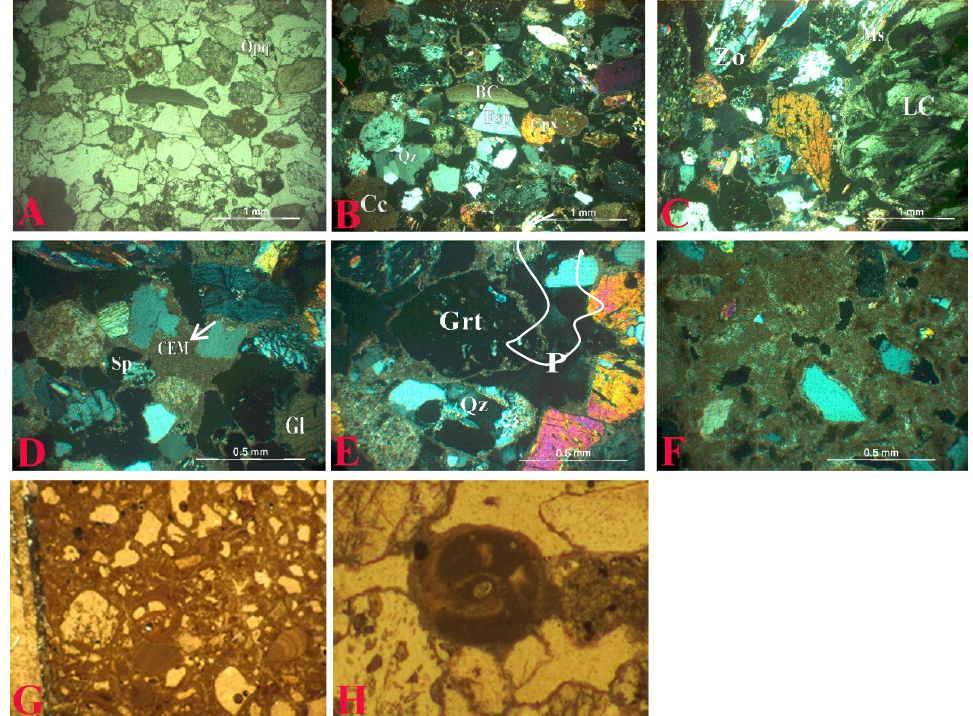
Figure 10. Photomicrographs of beachrocks of area 1. ( A , B ): Clastic texture in parallel and cross polarized light (XPL) respectively; ( C ): Lithoclast of chlorite schist participating in microstructure (XPL); ( D ): Cement fills pores. Note topically recrystallized micrite to microsparite (arrow) (XPL); ( E ): Cement as rims of grains and bridges between particles. Note micro-channel of porosity (white line) (XPL); ( F ):